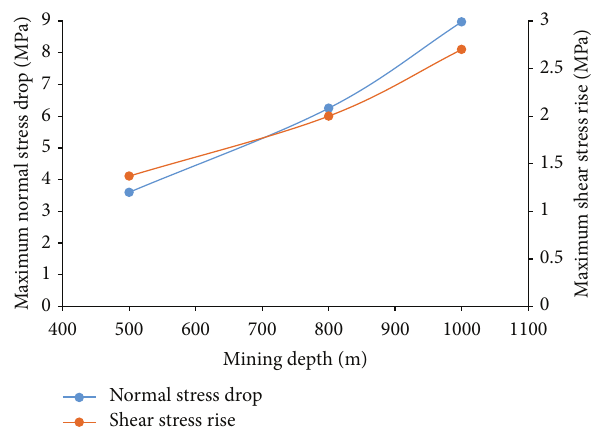
Figure 6: Effect of mining depth on the change in normal and shear stresses along the